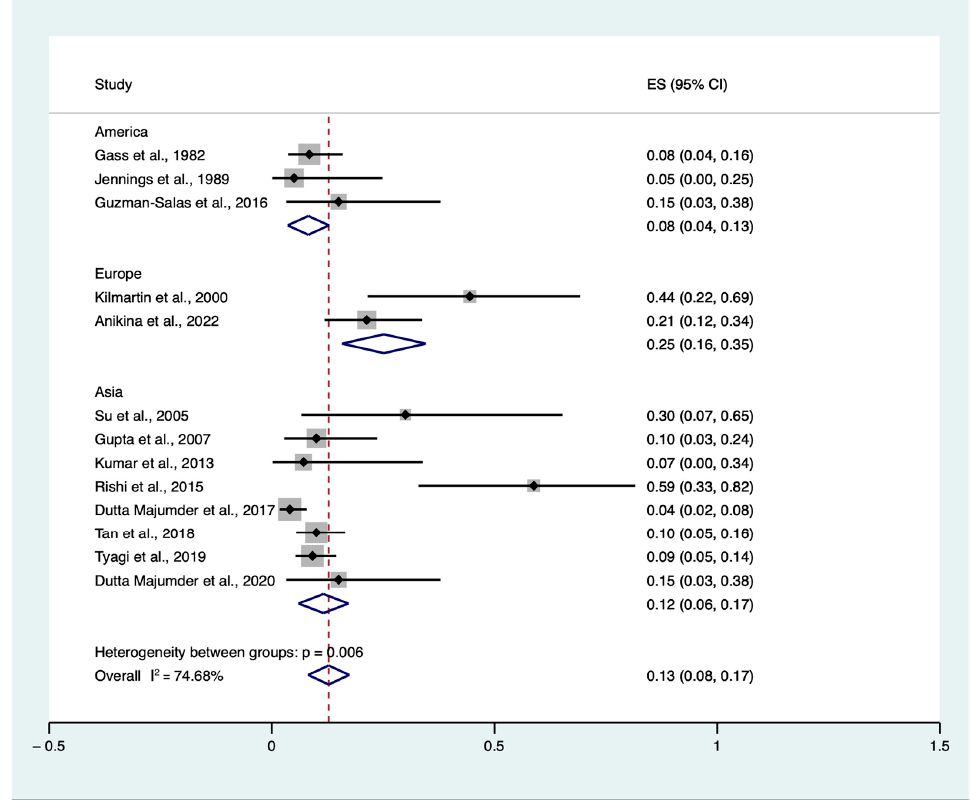
Figure 4. Proportional subgroup meta-analysis of cumulative sympathetic ophthalmia (SO) incidence triggered by single or multiple vitreoretinal (VR) surgery procedures in eyes without an antecedent history of trauma and previous ocular surgery, except for previous or concomitant une-